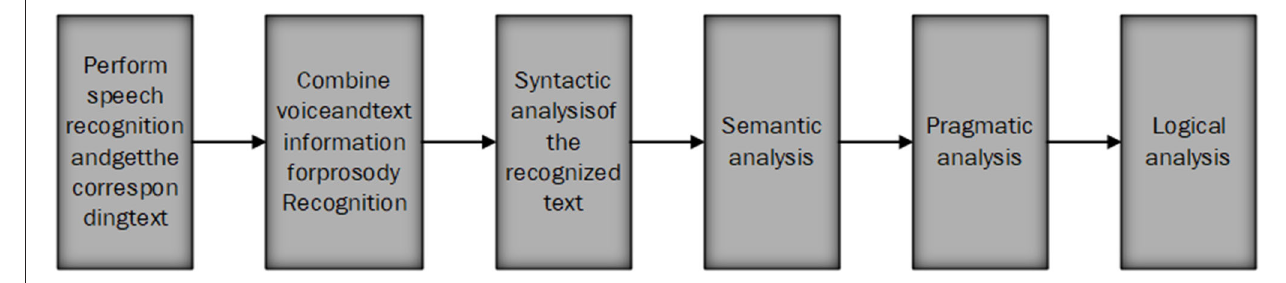
FIGURE 3 | Algorithm